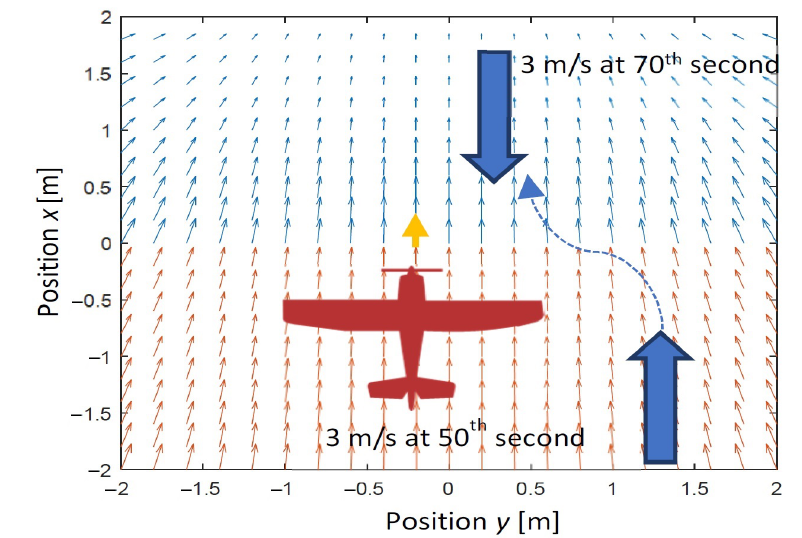
Figure 7. The second scenario of simulations for longitudinal wind gust case.